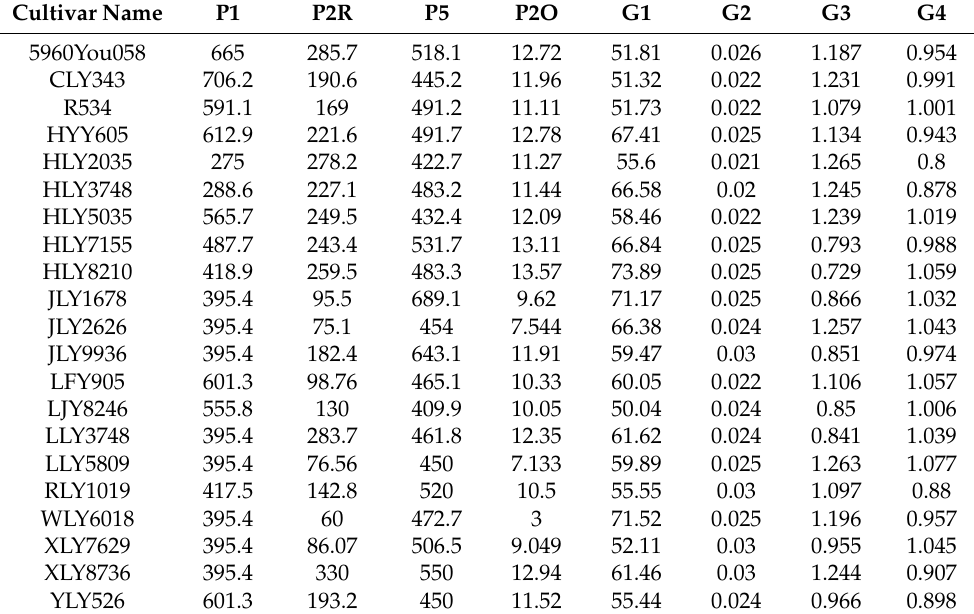
Table A3. Cultivar coefficients of rice varieties used in the CERES-Rice model.